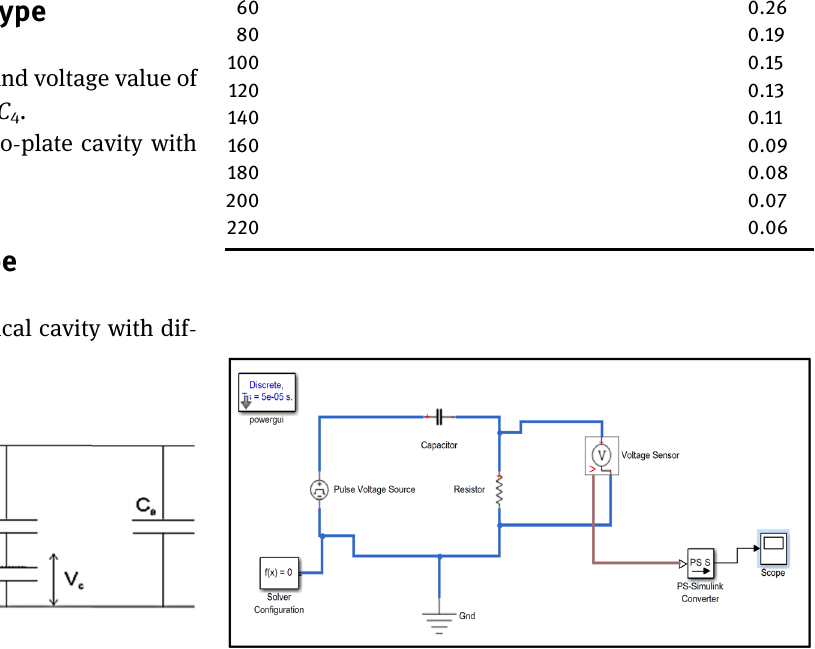
Figure 13: Matlab modeling of the PD - calibrated